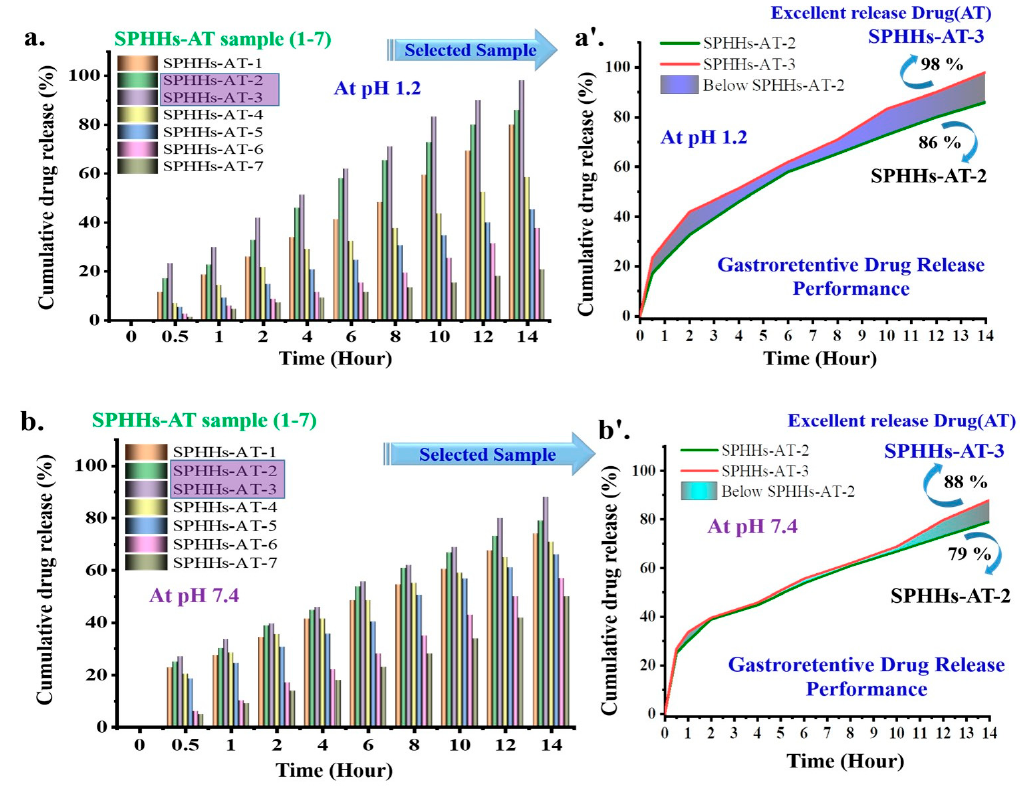
Figure 6. The in vitro drug release profile of AT-loaded SPHHs samples at two different pH values; ( a , a’ ) pH 1.2 and ( b , b’ ) pH 7.4, sequentially ( n = 3, mean ± standard deviation).